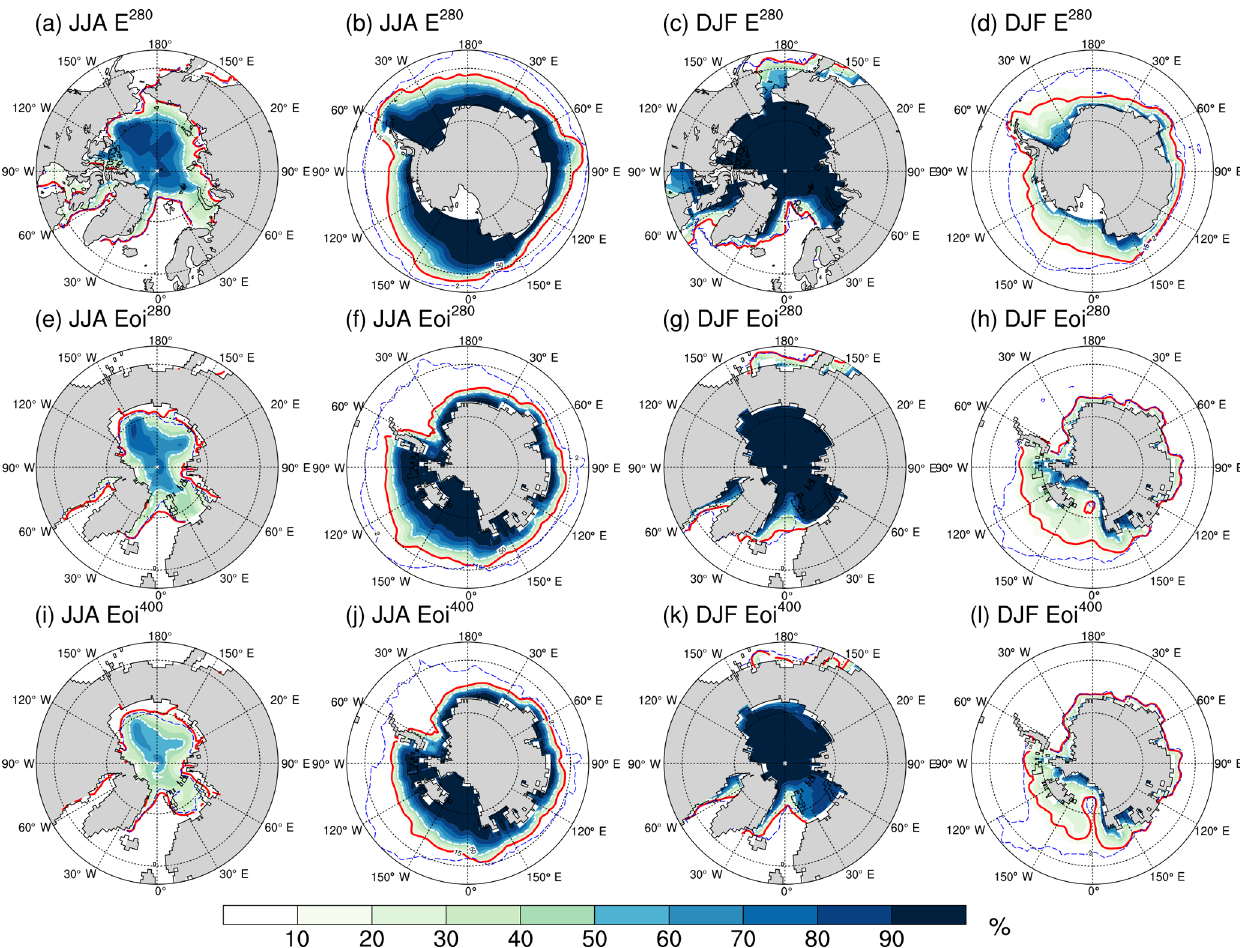
Figure 10. Sea ice concentrations (%) during JJA and DJF in the Northern and Southern Hemisphere for (a–d) E 280 , (e–h) Eoi 280 and (i–l) Eoi 400 . The red line indicates the sea ice edge based on a threshold of 15%, whilst the dotted white line indicates the 50% threshold. The dotted blue line indicates the 2 ◦ C isotherm; in the Southern Ocean, this is indicative of the Antarctic convergence zone (polar